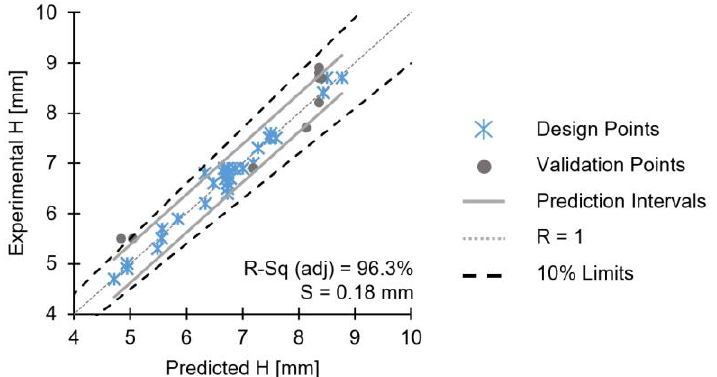
Figure 9. Validation diagrams for the reduced model of H.